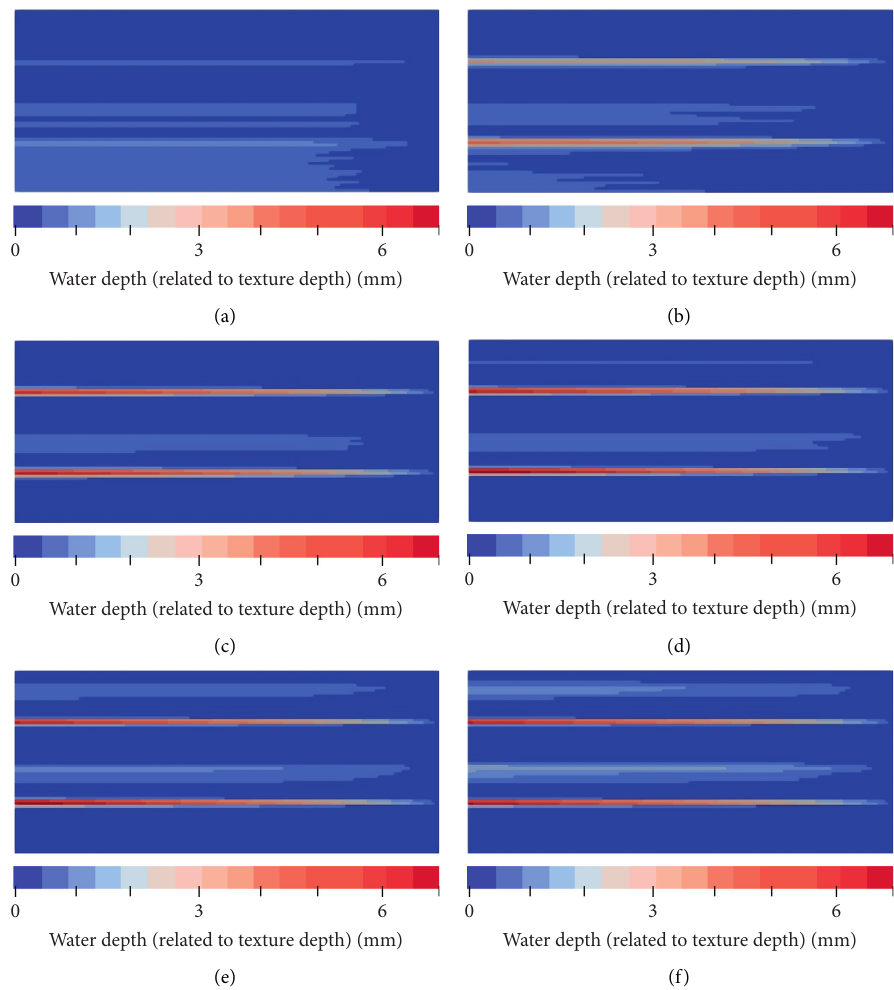
Figure 11: Example 4: effects of increasing rutting on the drainage of a pavement surface. (a) t � 1 year. (b) t � 5 years. (c) t � 10 years. (d) t � 15 years. (e) t � 20 years. (f) t � 30